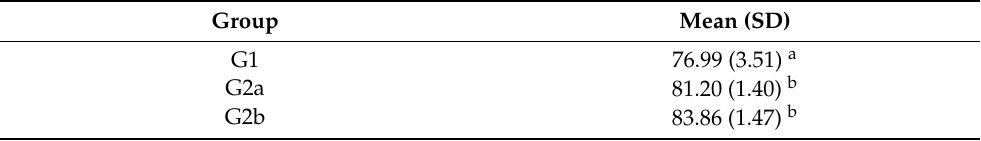
Table 4. Mean and standard deviation (SD) in 5th year students. Group Mean (SD) G1